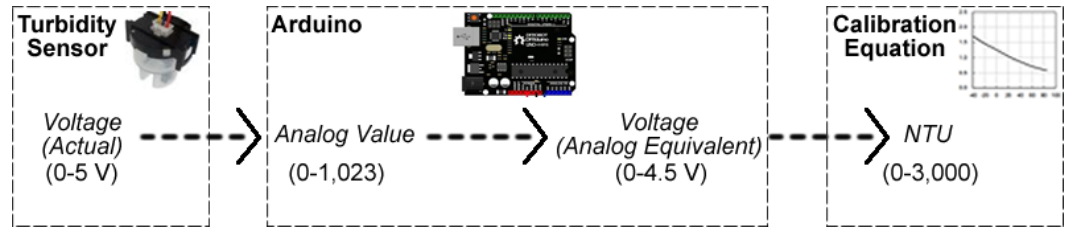
Figure 4. The process involved in converting an analogue sensor reading to a calibrated turbidity value.